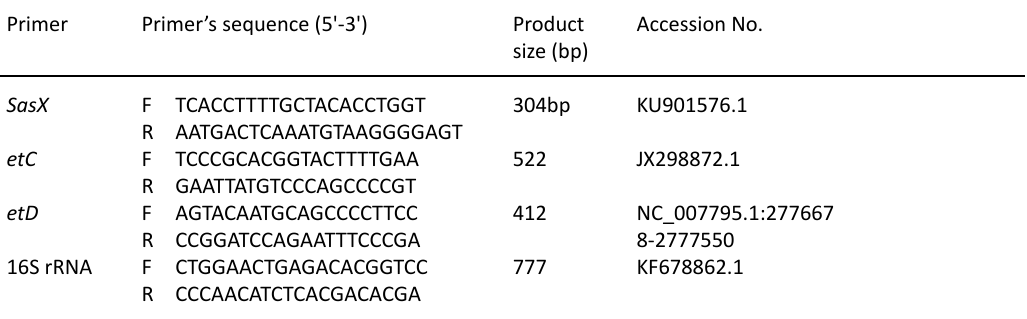
Table 1. All primer used in the current study, and the specific primer of 16S rRNA gene of S. aureus Primer Primer’s sequence (5'-3') Product Accession